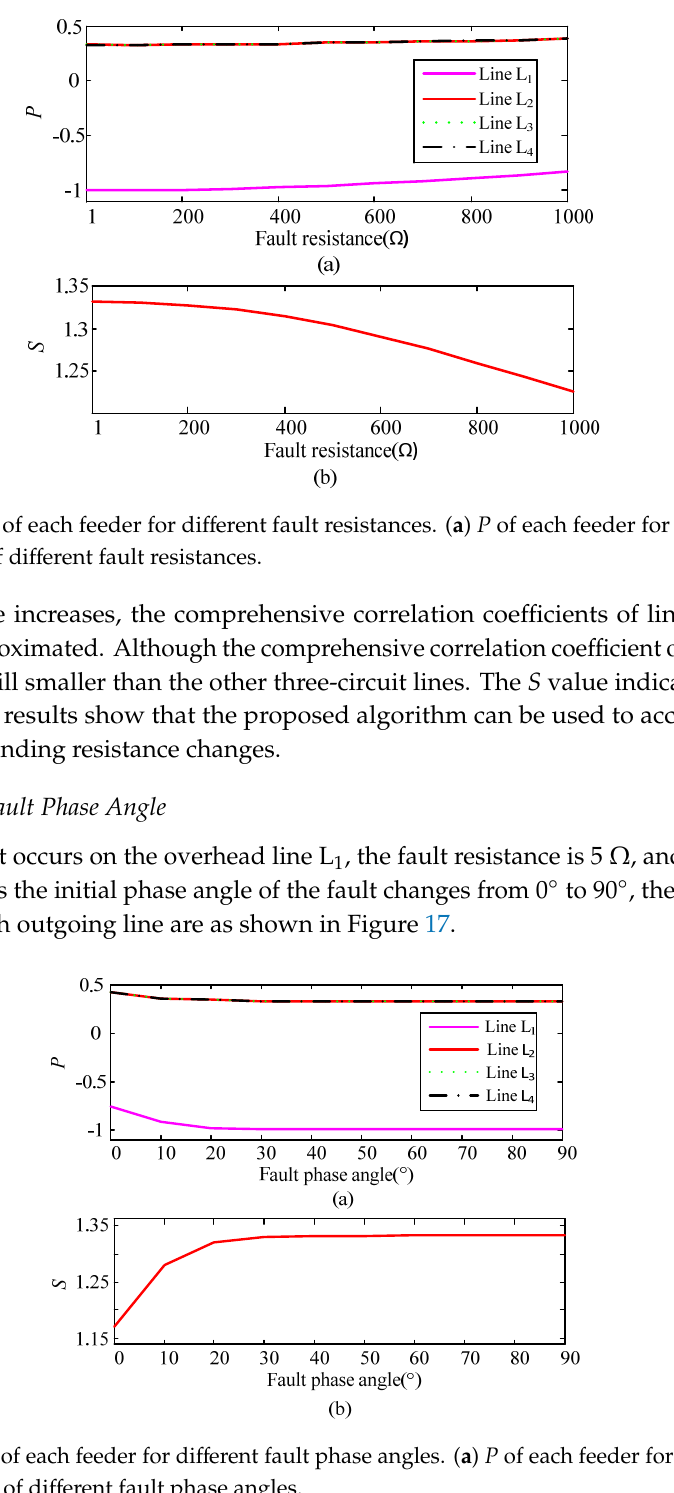
Figure 18. S and P of each feeder with distance variation. ( a ) P of each outgoing line with distance variation; ( b ) S of distance variation.